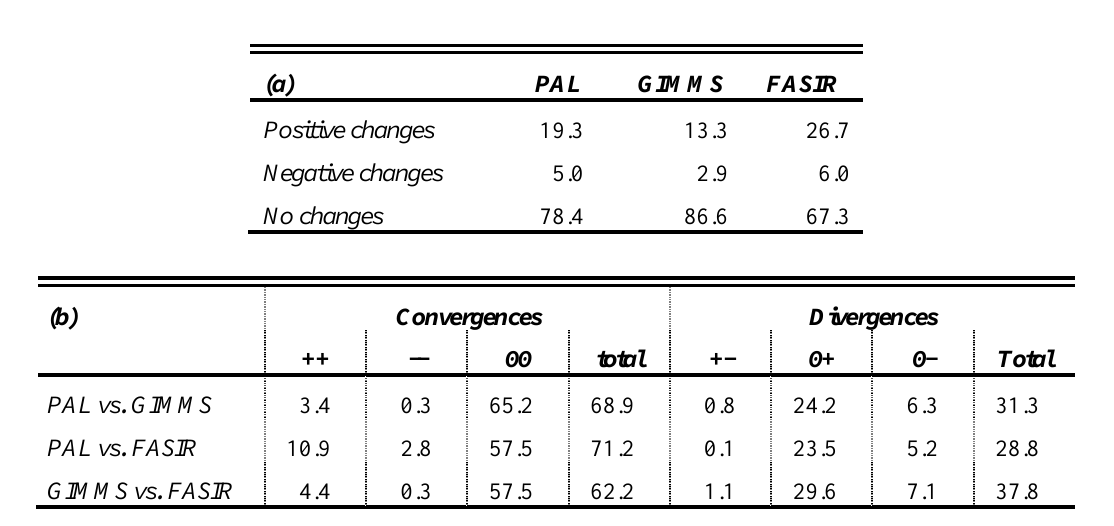
Table 3. In percentage of the total number of pixels, (a) distribution of the pixels in each of the three trend classes, and (b) convergences and divergences for the trend results among the three NOAA AVHRR data sets for the average annual NDVI. Acronyms: ++ positive/positive, -- negative/negative, 00 no change/no change, +- positive/negative, + 0 positive/no change, and - 0 negative/no change.